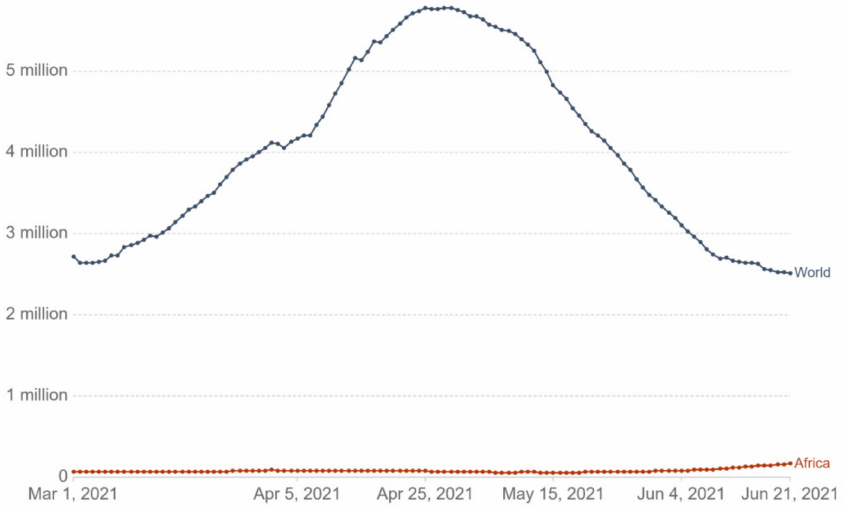
Figure 3. New weekly confirmed COVID-19 cases in Africa compared to the world after starting the vaccination campaigns (March 2021 to June 2021), each data point is the sum of COVID-19 cases reported within a week, source: Coronavirus vaccination statistics and research